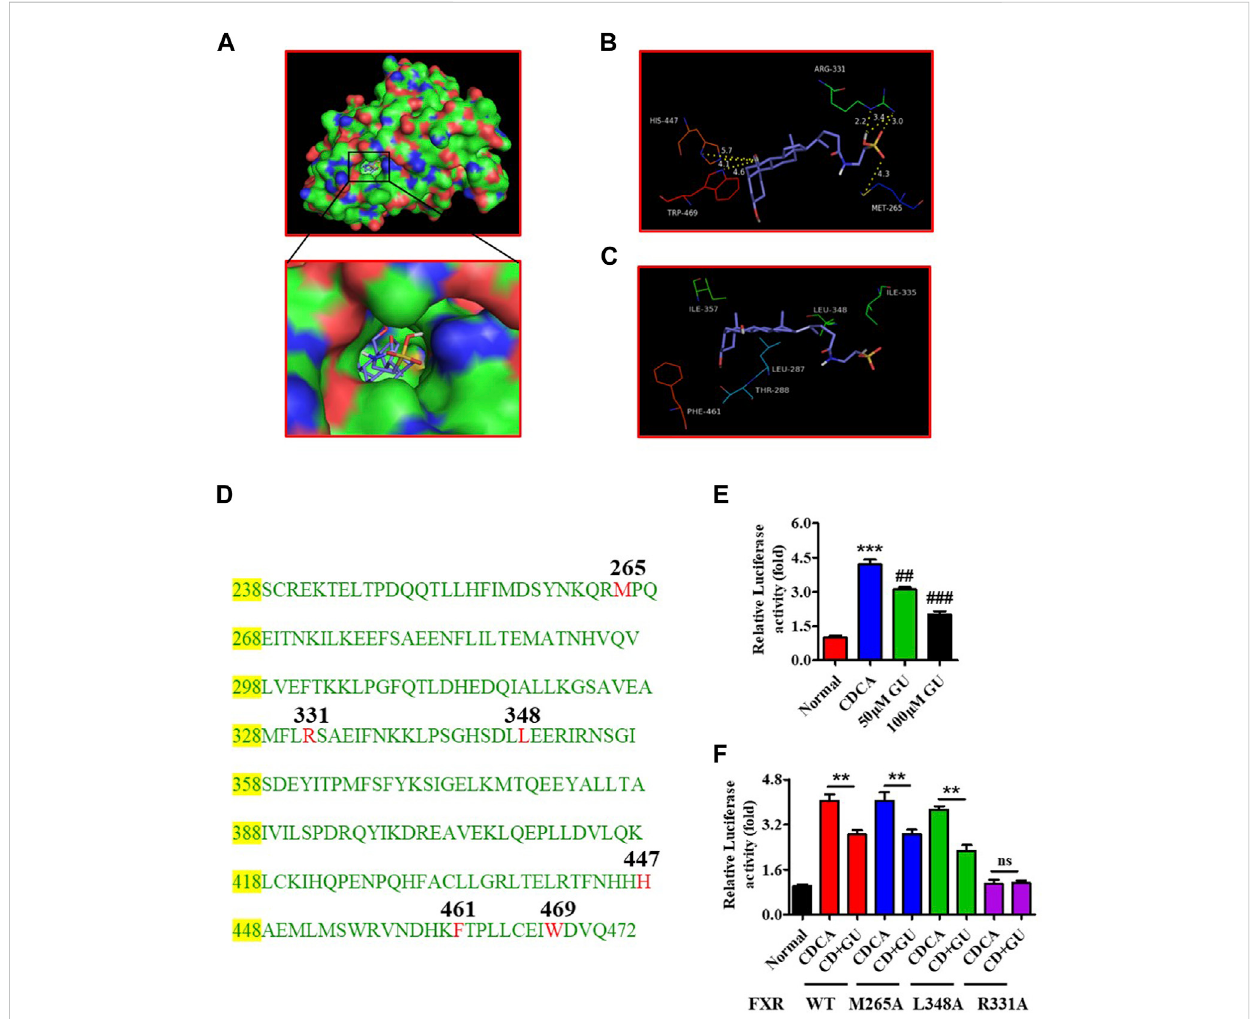
FIGURE 4 GUDCA is an antagonist of FXR. (A) The docked conformation of GUDCA with FXR (3DCT); (B) H-bond interaction of GUDCA with FXR residues; (C) Hydrophobicinteraction ofGUDCA withFXR residues; (D) Amino acidsequence ofFXR LBD; (E) Reporterassay fordetecting theeffect ofGUDCA